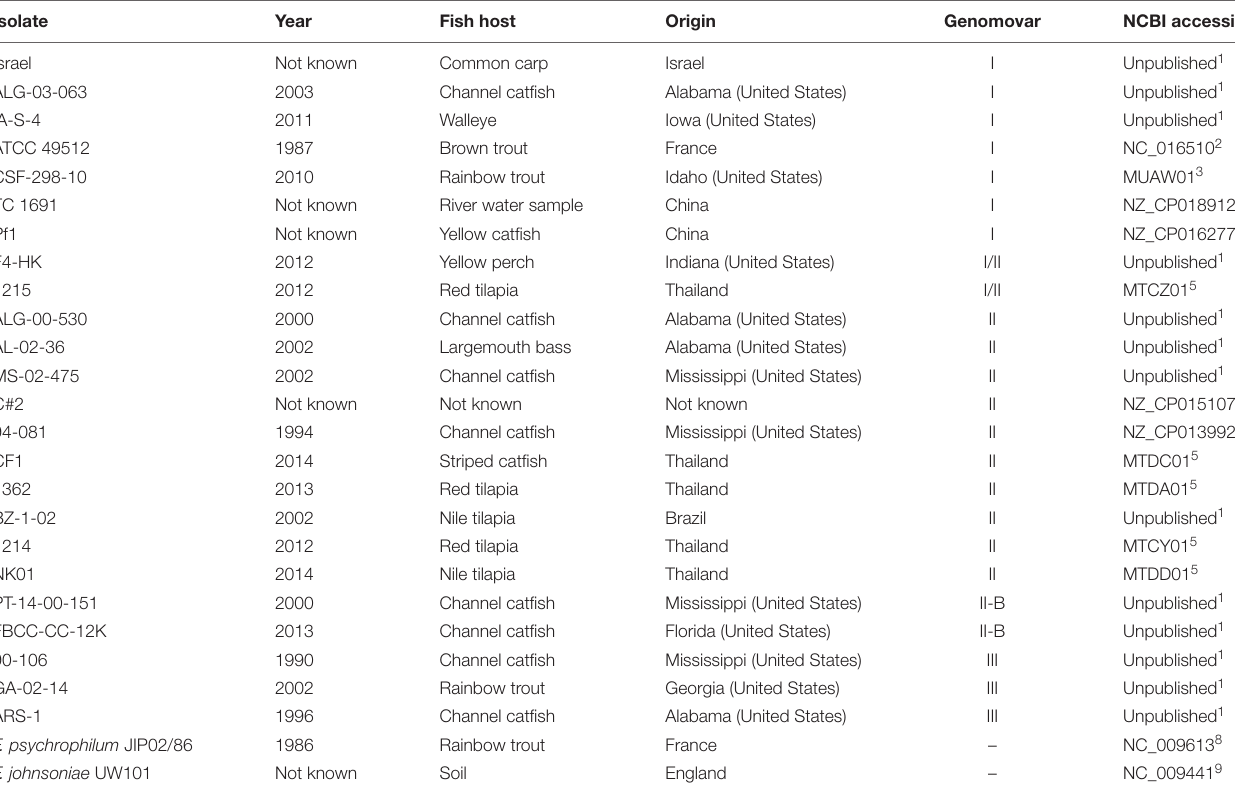
TABLE 3 | Description of Flavobacterium columnare , F. psychrophilum , and F. johnsoniae genomes analyzed in this study, including the year and fish host of isolation, geographic origin, genomovar assignment, and NCBI accession number.